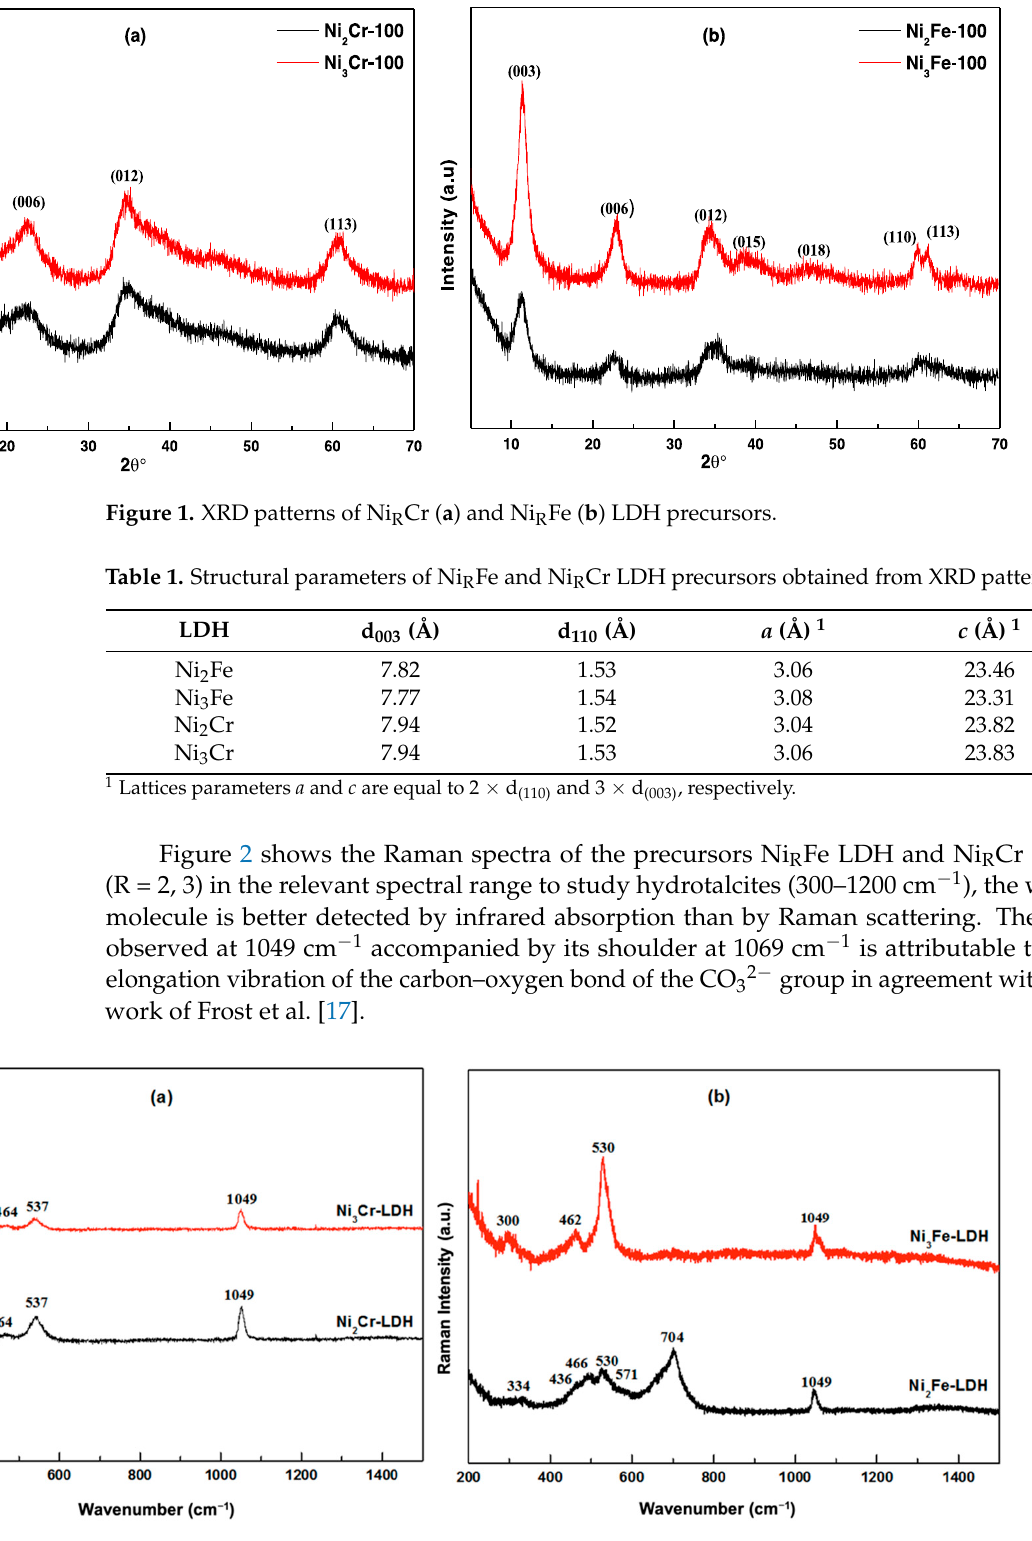
Figure 2. Raman spectra of Ni R Cr ( a ) and Ni R Fe ( b ) LDH precursors.